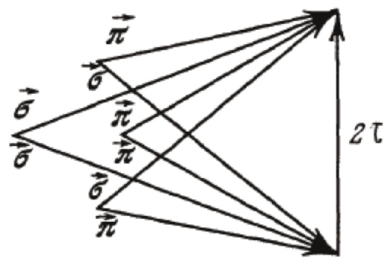
Figure 7. Second order Bragg conditions in vector form for a CLC with a strong local birefringence (polarization symbols π and σ at the wave vectors show Eigen waves polarizations related to the corresponding propagation direction).